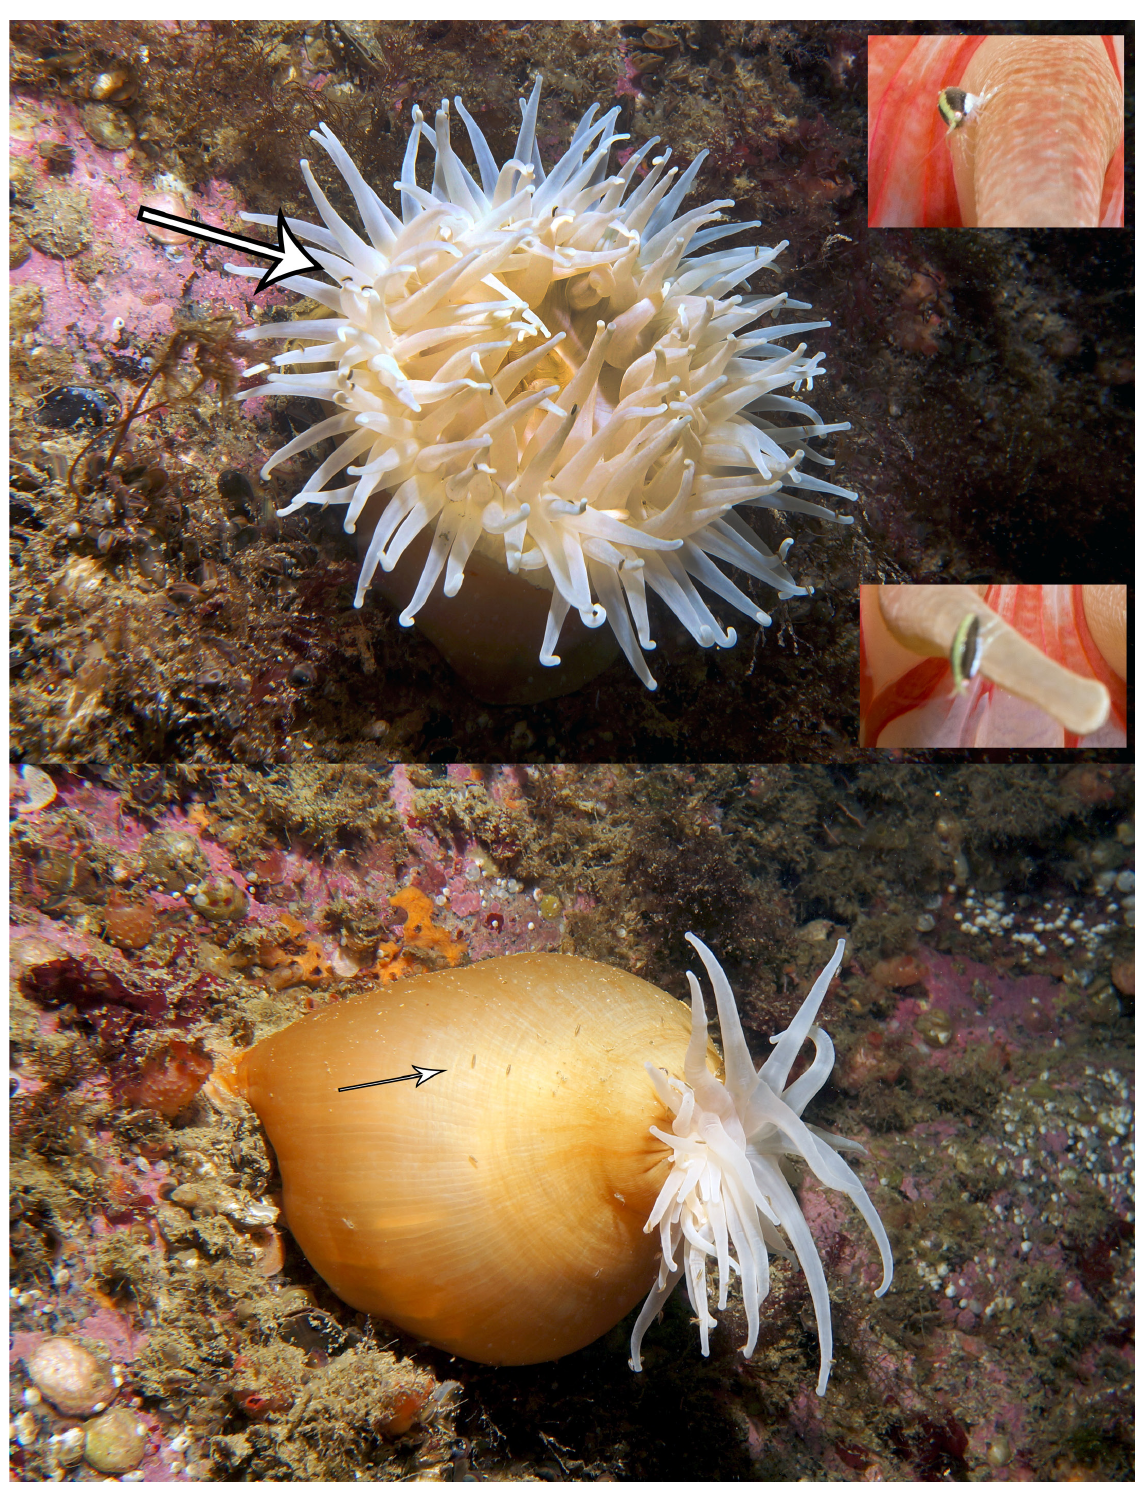
Fig. 6. Photo in situ of the sea anemone Urticina eques (Gosse, 1858) with associated amphipods Pleusymtes actiniae sp. nov. from Dolgaya Bay, Barents